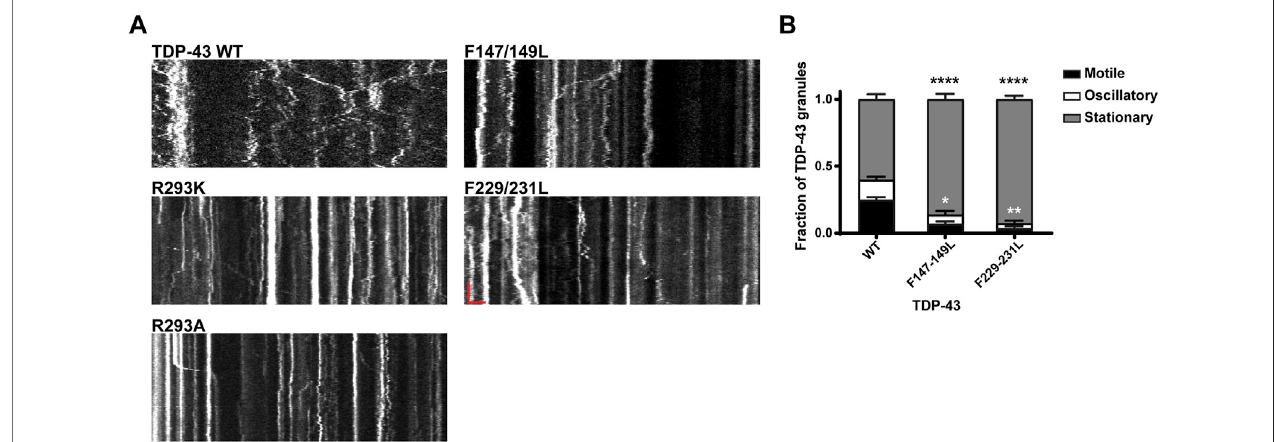
FIGURE7| NeuronalRNPgranulescomposed ofTDP-43RRM1/RRM2 mutants exhibitreduced motility. (A) RepresentativekymographsofGFPtagged TDP-43 WT, RGG mutant, or RRM1/2 mutant RNP granules are shown. In the kymographs, the retrograde direction (towards the Soma) is to the left and the anterograde directionistotheright.Thescalebar(horizontalredline)correspondsto3 μ m( x axis)andtimescale(verticalredline)correspondsto50 s( y axis). (B) FractionofTDP-43 WT or RRM1/2 mutant RNP granules that are stationary, oscillatory, or motile in the axon; motile puncta ≥ 10 μ m net displacement in 5 min. TDP-43 RRM1 (F147- 149L) and RRM2 (F229-231L) mutants exhibit signi fi cantly reduced motile (black asterisk) and oscillatory fraction (white asterisk), compared to WT. For each condition, n = 11 – 12 neurons were analyzed from 3 independent experiments ( N = 3). Error bars represent standard error mean. One way ANOVA with Dunnett ’ s correction for multiple comparisons was used to determine statistically signi fi cant differences among samples; * p < 0.05, ** p < 0.01, and **** p <